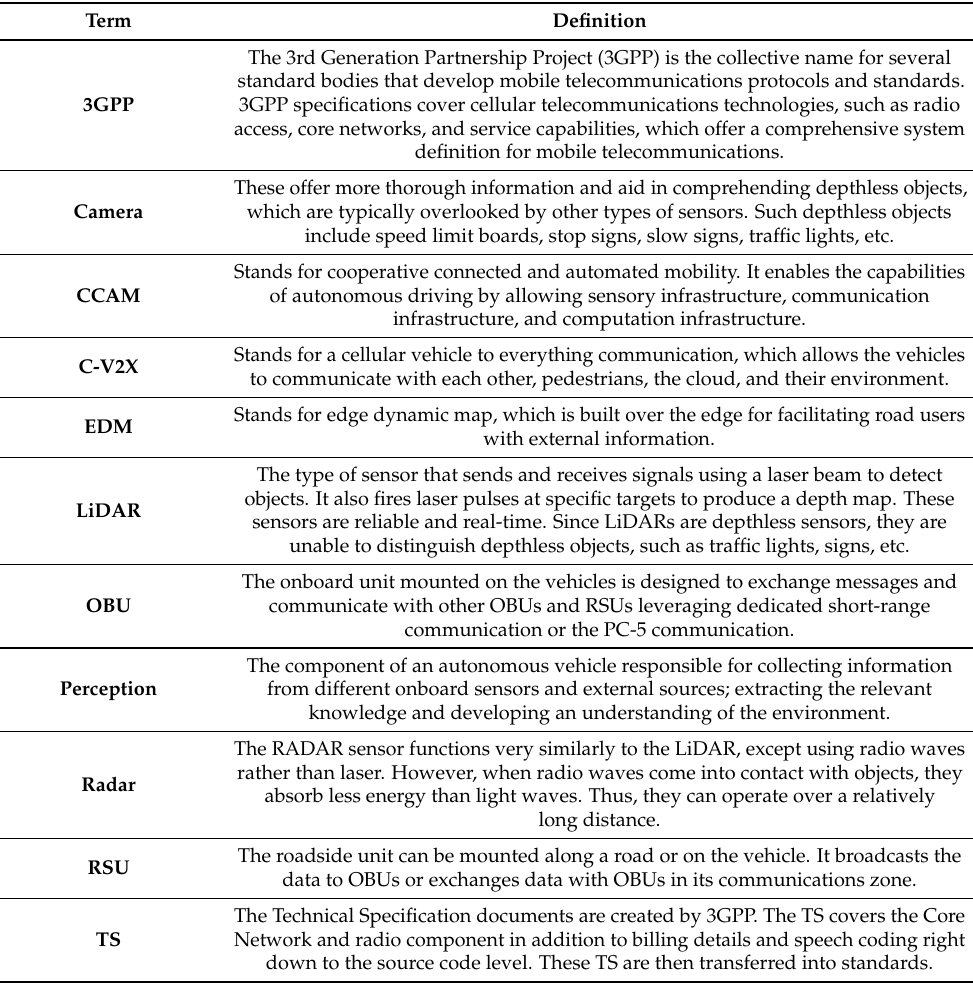
Table 4. Glossary